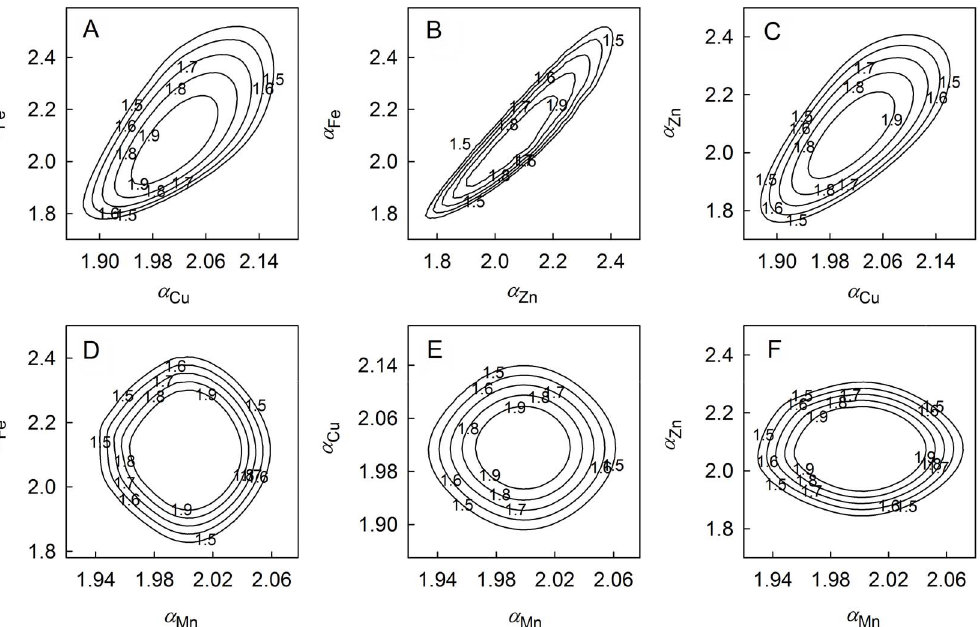
Figure 4. Joint multifractal spectrum for selected soil trace elements at 2 15 to 15 range of q evaluated at 1 increment.